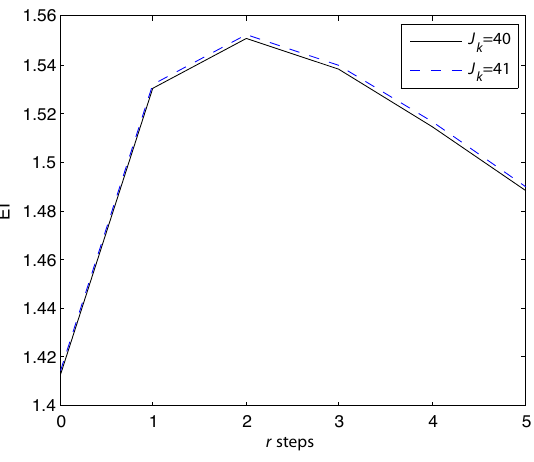
Fig. 1. Function of the efficiency index